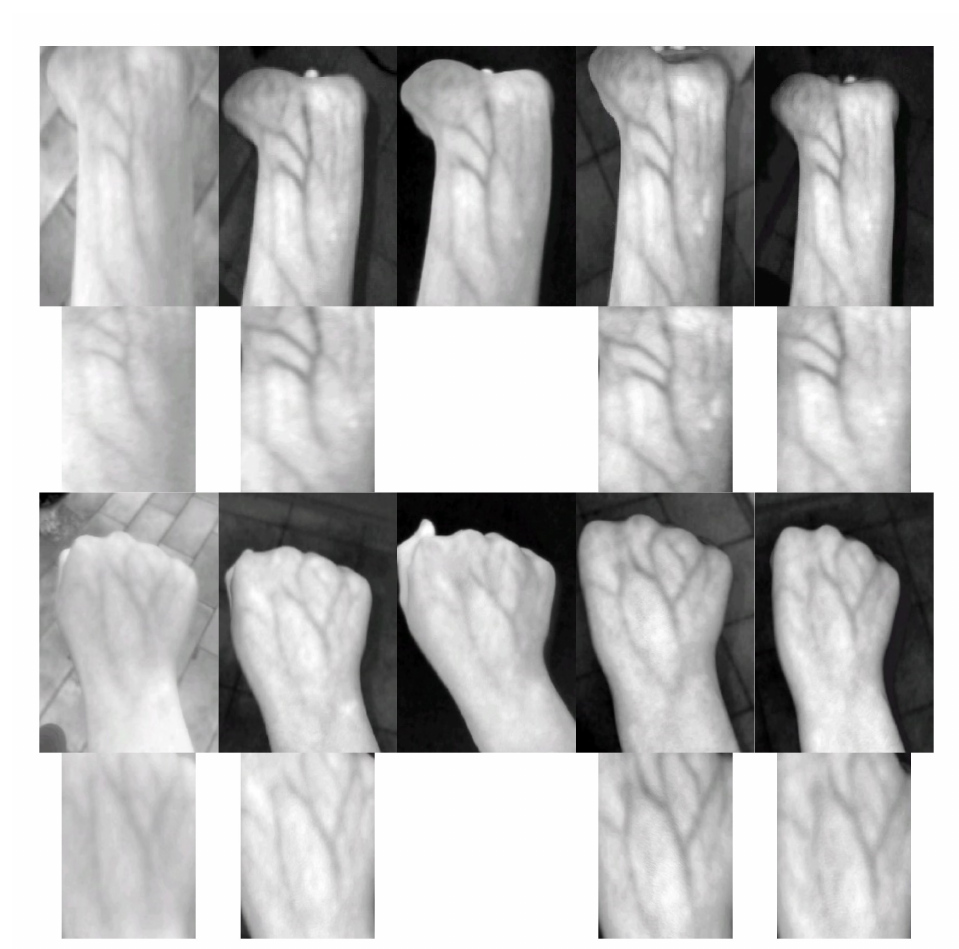
Figure 2. Samples acquired from a wrist ( first row ) and a dorsal hand ( third row ) together with their extracted ROIs if applicable ( second and fourth rows , respectively) for the conditions (from left to right): Outdoor, Indoor natural light 1, Indoor natural light 2, Indoor artificial light, and